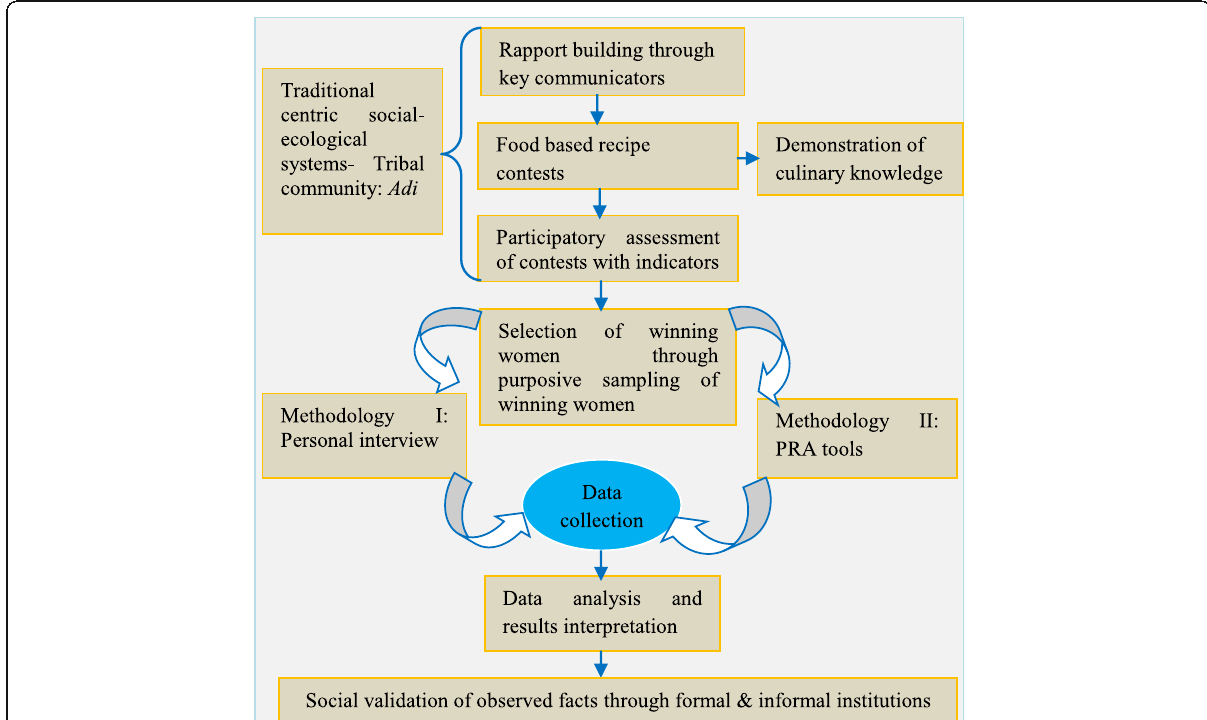
Fig. 2 Schematic presentation of exploratory research